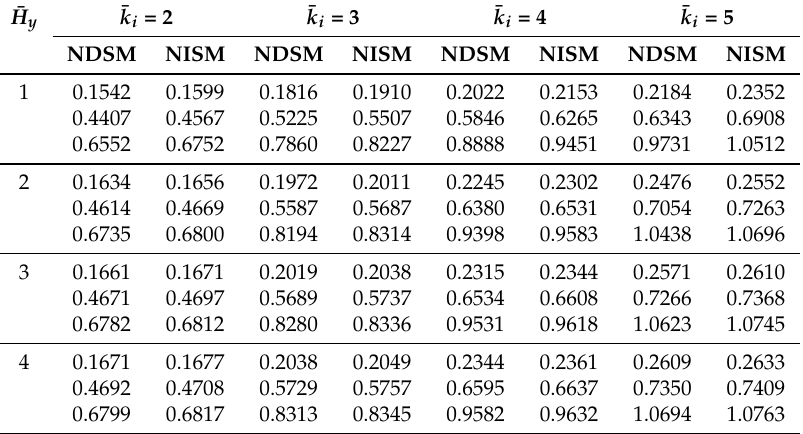
Table 5. A verification between the predicted first three longitudinal frequencies of the magnetically affected nanorod with FIFR ends according to the NDSM and those of the NISM ( l b = 20 nm, N = 3, D 0 = 4 nm, e 0 a = 1